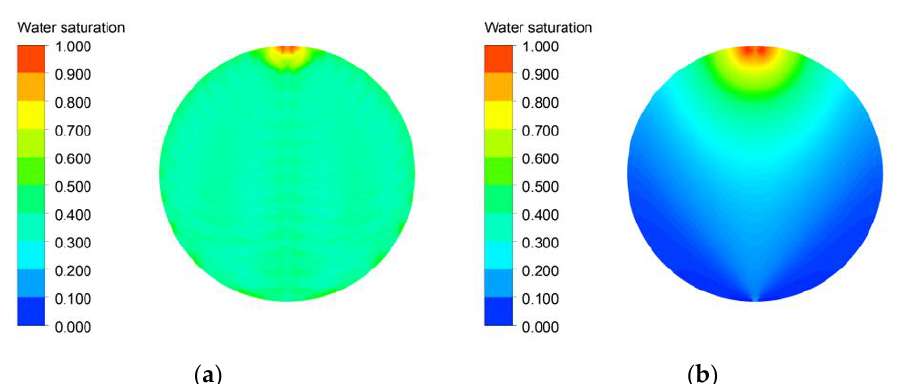
Figure 9. PEMWE’s water saturation distribution on the active area with ( a ) the channel flow field and ( b ) the PTL flow field ( ε : 0.75, K : 30.2 × 10 −12 m 2 , θ : 30°, 𝑄̇ 𝑖𝑛 : 10 sccm, T in : 328.15 K, T cell : 328.15 K, V op : 1.8 V and 𝑔 : z+).